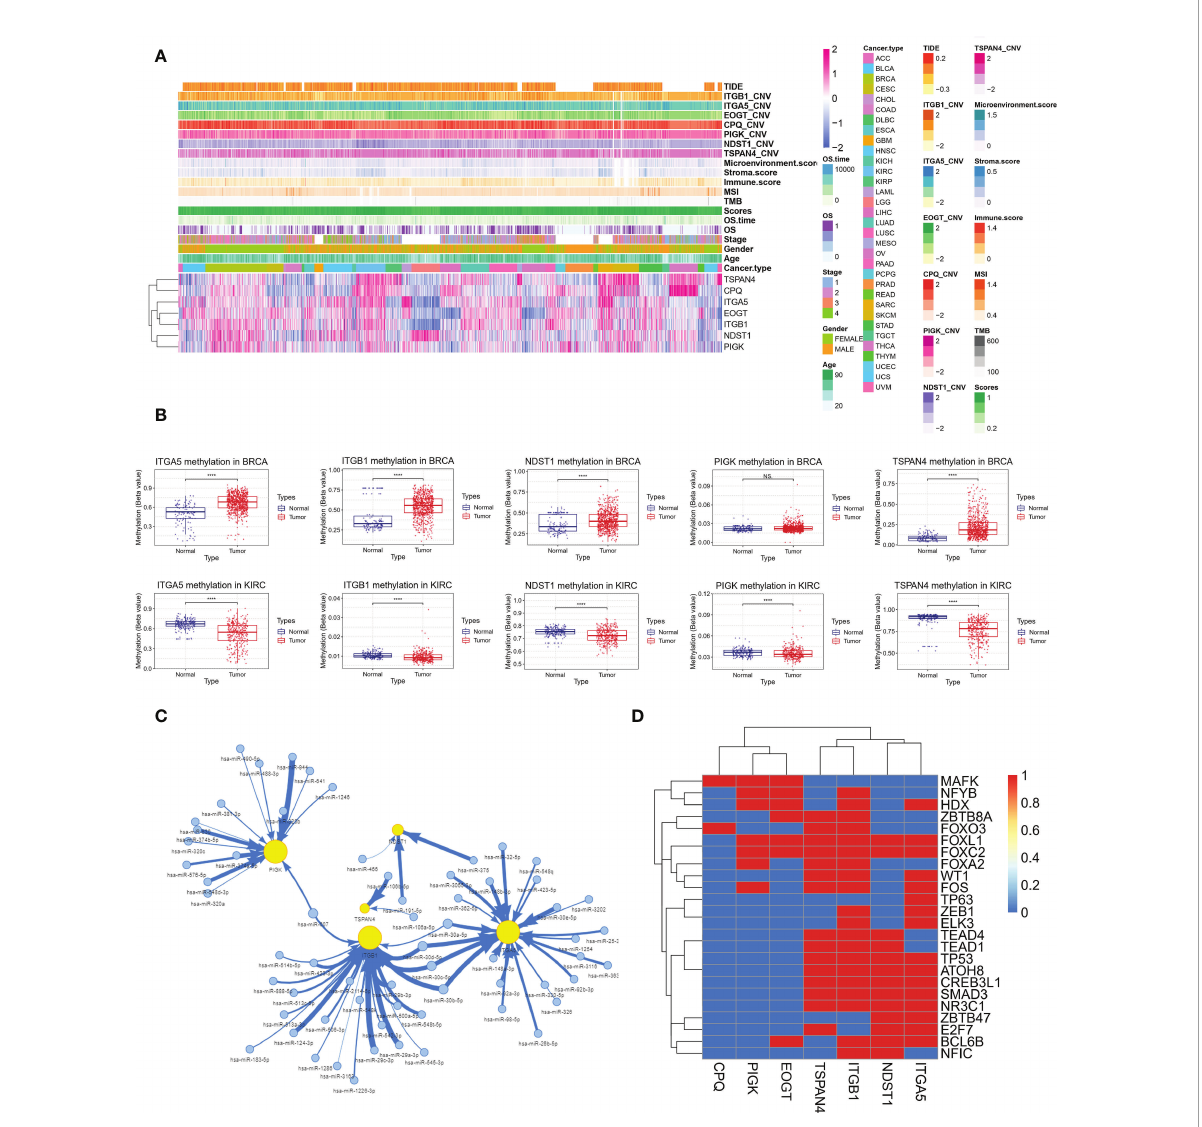
FIGURE 13 Integrative analysis of multi-omics data of MRGs to fi nd potential co-regulatory mechanisms. (A) Correlation of MRGs expression with migrasome score, tumor type, tumor stage, gender, age, overall survival, TMB, MSI, immune microenvironment score, CNV and TIDE score. (B) Altered methylation levels of ITGA5, ITGB1, NDST1, PIGK and TSPAN4 in BRCA and KIRC. ****P < 0.0001, NS, no signi fi cant. (C) The miRNA regulatory network shows miRNA-gene targeting relationships of ITGA5, ITGB1, NDST1, PIGK and TSPAN4 in BRCA and KIRC in BRCA and KIRC. (D) Correlation of MRGs and transcription